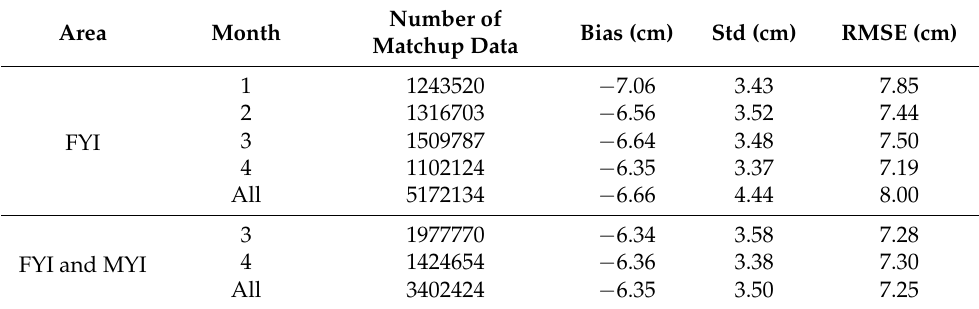
Table 8. Statistics of snow depth differences (RSD minus